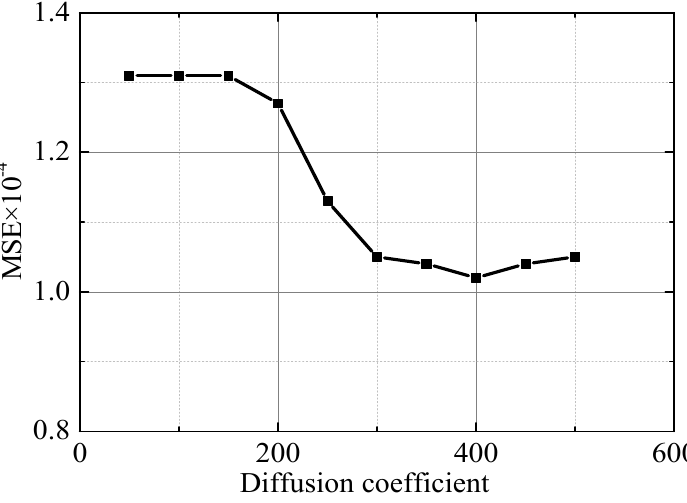
Figure 11. Predicted error responses in comparison with diffusion coefficient. The RBF-NNM was used to predict the trend of the signal sample, as shown in Figure 12. From it, it appeared that the RBF-NNM can also predict the changing trend of the flow field signal.